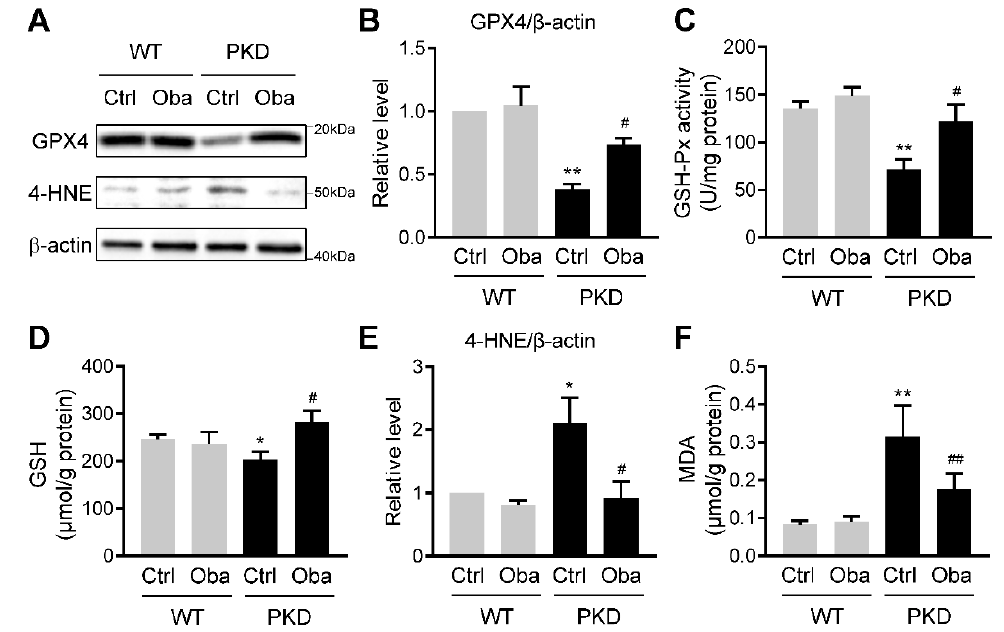
Figure 6. Inhibition effect of obacunone on lipid peroxidation. ( A ) Representative Western blots of GPX4 and 4-HNE in the kidneys of wild-type (WT) and PKD (PKD) mice treated without (Ctrl) or with obacunone (Oba). ( B ) Quantification of GPX4 expression levels. ( C ) GSH-Px activity. ( D ) GSH content. ( E ) Quantification of 4-HNE expression levels. ( F ) MDA content. Data are presented as means ± SEM. n = 6. * p < 0.05, ** p < 0.01 versus WT-Ctrl. # p < 0.05, ## p < 0.01 versus PKD-Ctrl.